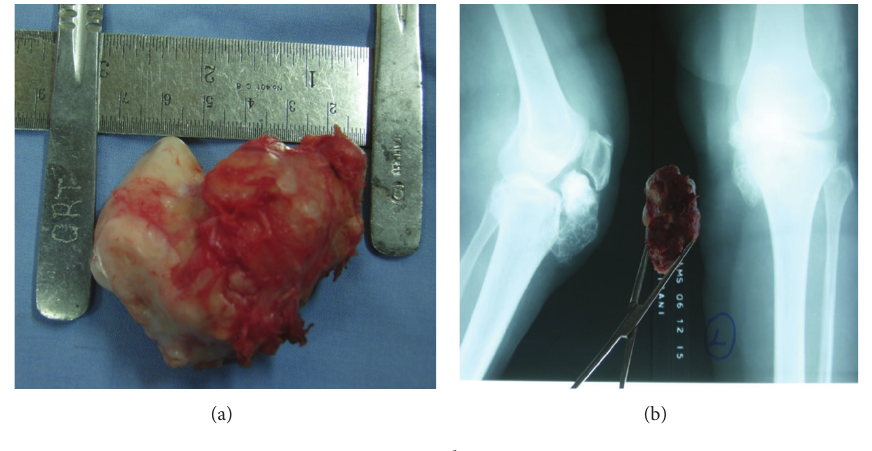
Figure 5: Excised mass in